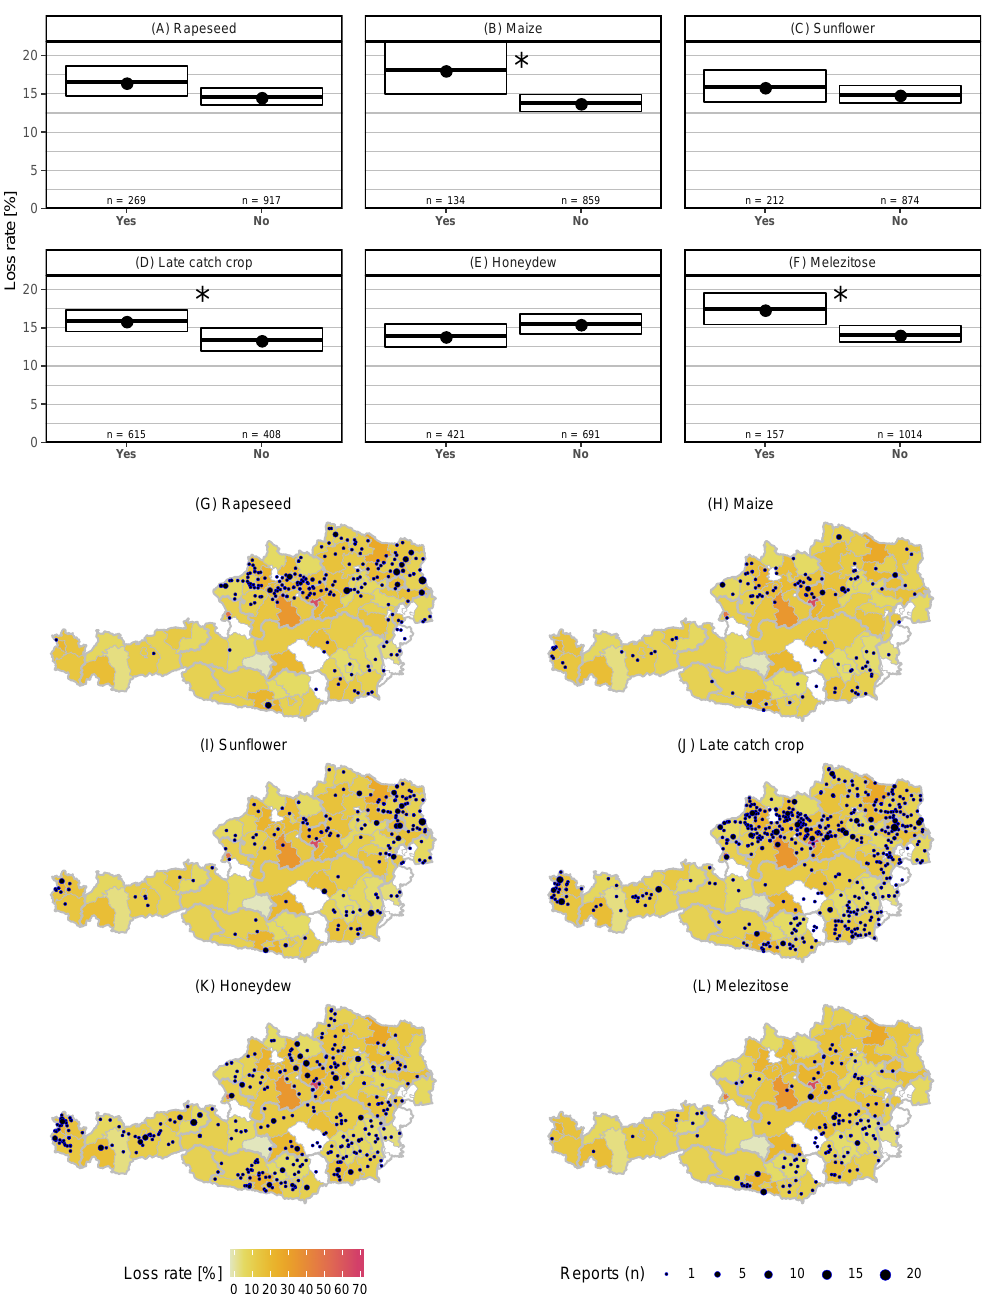
Figure A1. Six different types of crops (A = oilseed rape— Brassica napus , B = maize— Zea mays , C = sunflower— Helianthus annuus , D = late catch crop, E = honeydew, F = Melezitose) and their winter honey bee colony loss rates (and 95% CI): The maps indicate the rough location of the main wintering apiary of the participants. Multiple crop reports were possible, which means that different crops could apply to the same